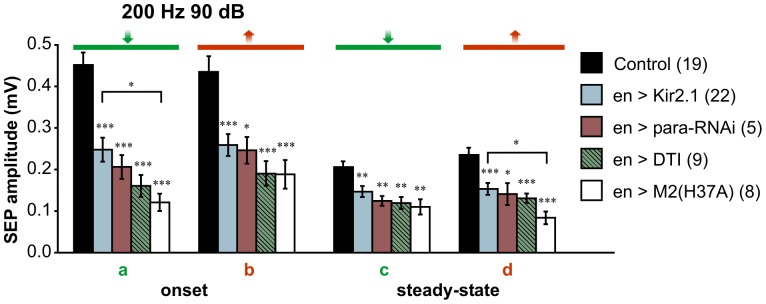
Silencing or poisoning En-expressing JONs affects sound responses similarly.Mean amplitude histograms of the SEPs measured as designated in Fig. 4 for 200 Hz in flies whose JONs expressing En were silenced or poisoned. Silencing was achieved by ectopic expression of the human hyperpolarizing potassium channel Kir2.1 (same bar as figure 4) or by knock-down of the Drosophila Na+ channel alpha subunit (para-RNAi). Poisoning was achieved by expression of the attenuated diphtheria toxin DTI or the modified influenza toxin M2(H37A). Silencing or poisoning led to a reduction of all SEPs measured. Genotypes: en-GAL4/+; UAS-Kir2.1,tub-GAL80ts/+ or en-GAL4/tub-GAL80ts; UAS-M2(H37A)-3ME/+ raised at 18-20°C (control); en-GAL4/+; UAS-Kir2.1,tub-GAL80ts/+ flies treated at 30°C (en>Kir2.1), UAS-Dcr2, w1118/+; en-GAL4/+; UAS-para-RNAi/UAS-2xEGFP (en >para-RNAi), en-GAL4/tub-Gal80ts; UAS-DTI/+ (en>DTI), en-GAL4/tub-GAL80ts; UAS-M2(H37A)-3ME/+ (en>M2(H37A)). Numbers in parenthesis indicate the number of flies tested for each experimental condition. Significant difference between means of each experimental group vs. control was assessed using a T-test. Significance between experimental groups was assessed with a one-way ANOVA followed by a post-hoc Tukey test. *** p<0.001, ** p<0.01, * p<0.05.